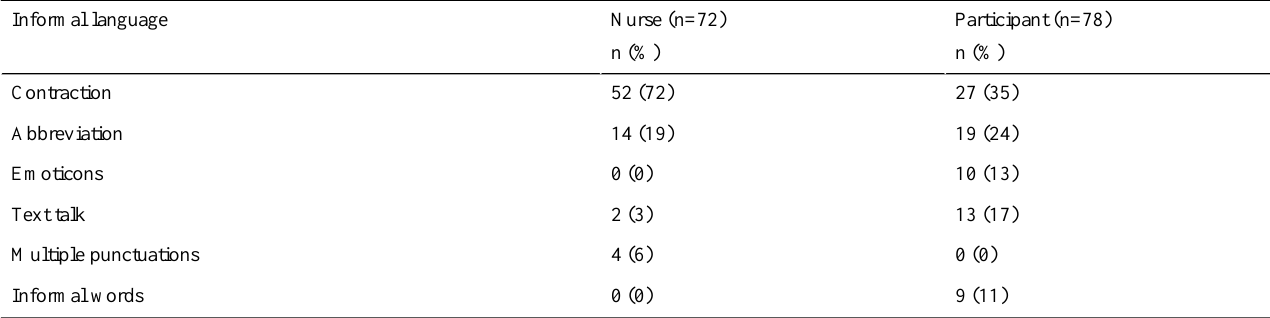
Table 2. Instances of informal language in texting